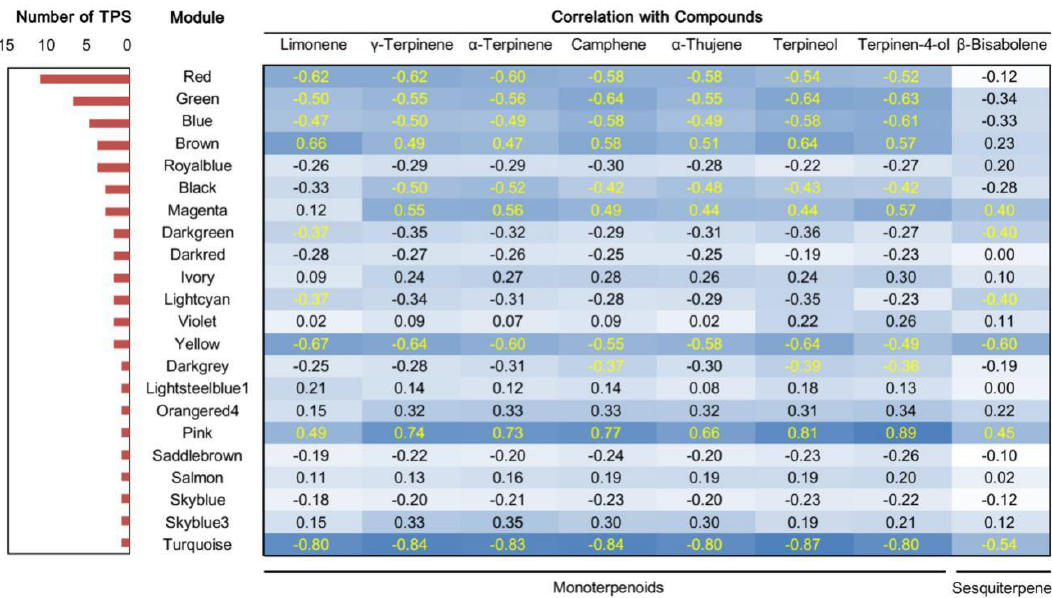
Figure 6. Correlation coefficients between terpene synthase (TPS), module and volatile compound. TPS numbers assigned to each module are list on the left. Correlation coefficients between volatiles and Module eigengenes are presented on the right with a color scale ( – 1 to 1). Darker blue color represents higher correlation. Coefficients with p < 0.05 are colored in yellow.